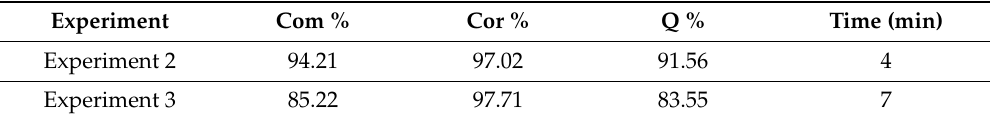
Table 3. Results of the proposed